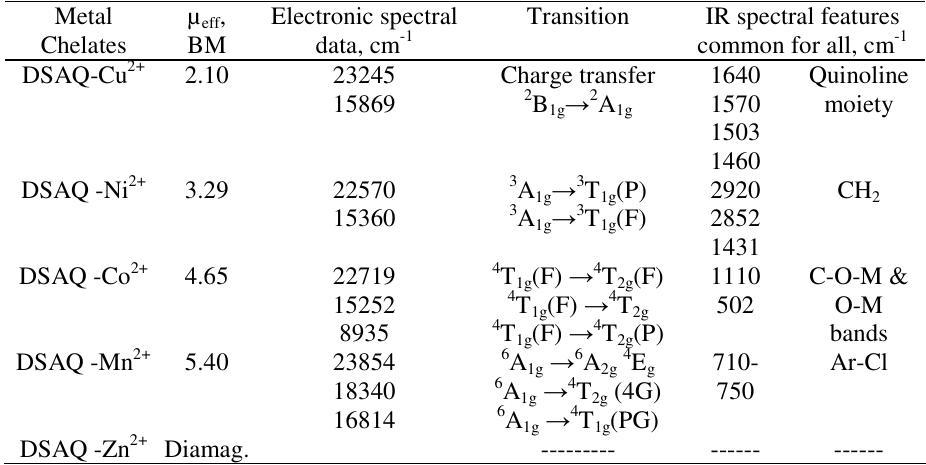
Table 2. Spectral features and magnetic moment of DSAQ metal chelates.